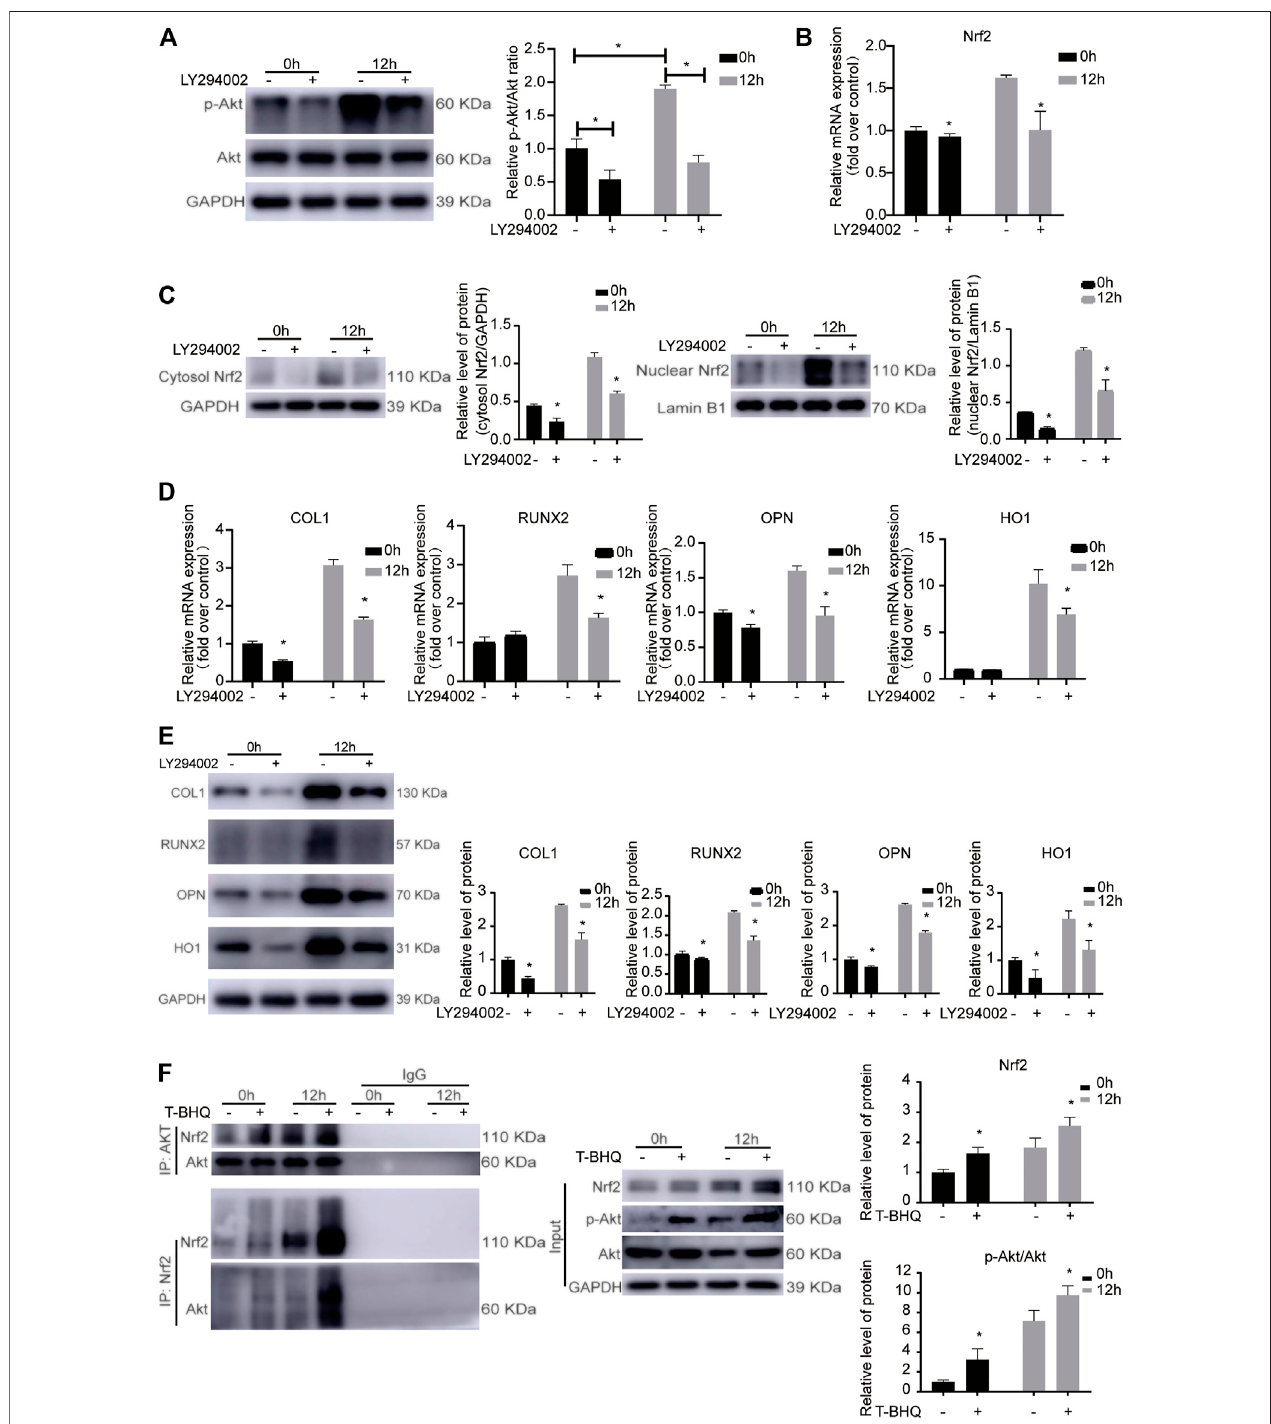
FIGURE 3 | The involvement of PI3K/Akt signaling pathway in the Nrf2 activation during the cyclic mechanical stress-stimulated osteogenic differentiation of PDLSCs. (A) LY294002, the PI3K inhibitor, inhibited the level of p-Akt under cyclic mechanical stress based on the western blotting experiments. (B) LY294002 down- regulated the Nrf2 mRNA under cyclic mechanical stress in PDLSCs. (C) LY294002 decreased the cytosol and nuclear protein expression level of Nrf2 under cyclic mechanicalstressinPDLSCs. (D) LY294002inhibited themRNAlevelsofosteogenicrelativemarkers(COL1, RUNX2andOPN)andHO1undercyclicmechanical stressinPDLSCs. (E) LY294002inhibitedtheproteinexpressionlevelsofosteogenicrelativemarkers(COL1,RUNX2andOPN)andHO1undercyclicmechanicalstress inPDLSCs. (F) Co-IP experiments showed theprotein-proteininteraction between Aktand Nrf2inPDLSCsasimmunoprecipitationwithanti-Aktantibodyand anti-Nrf2 antibody to enrich the protein complex, respectively.